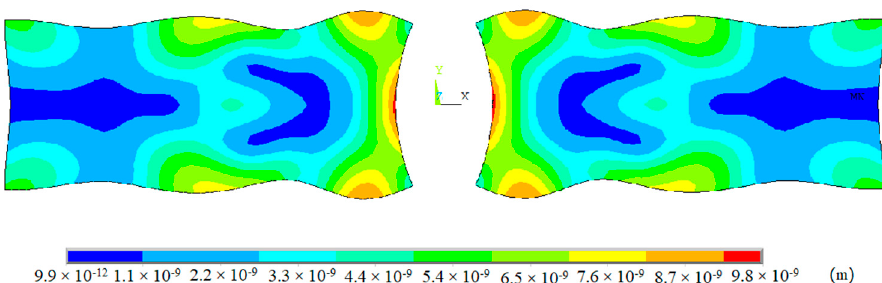
Figure 6. The side views of a full scale at 203 kHz of piezoelectric disc with a hole in the center.